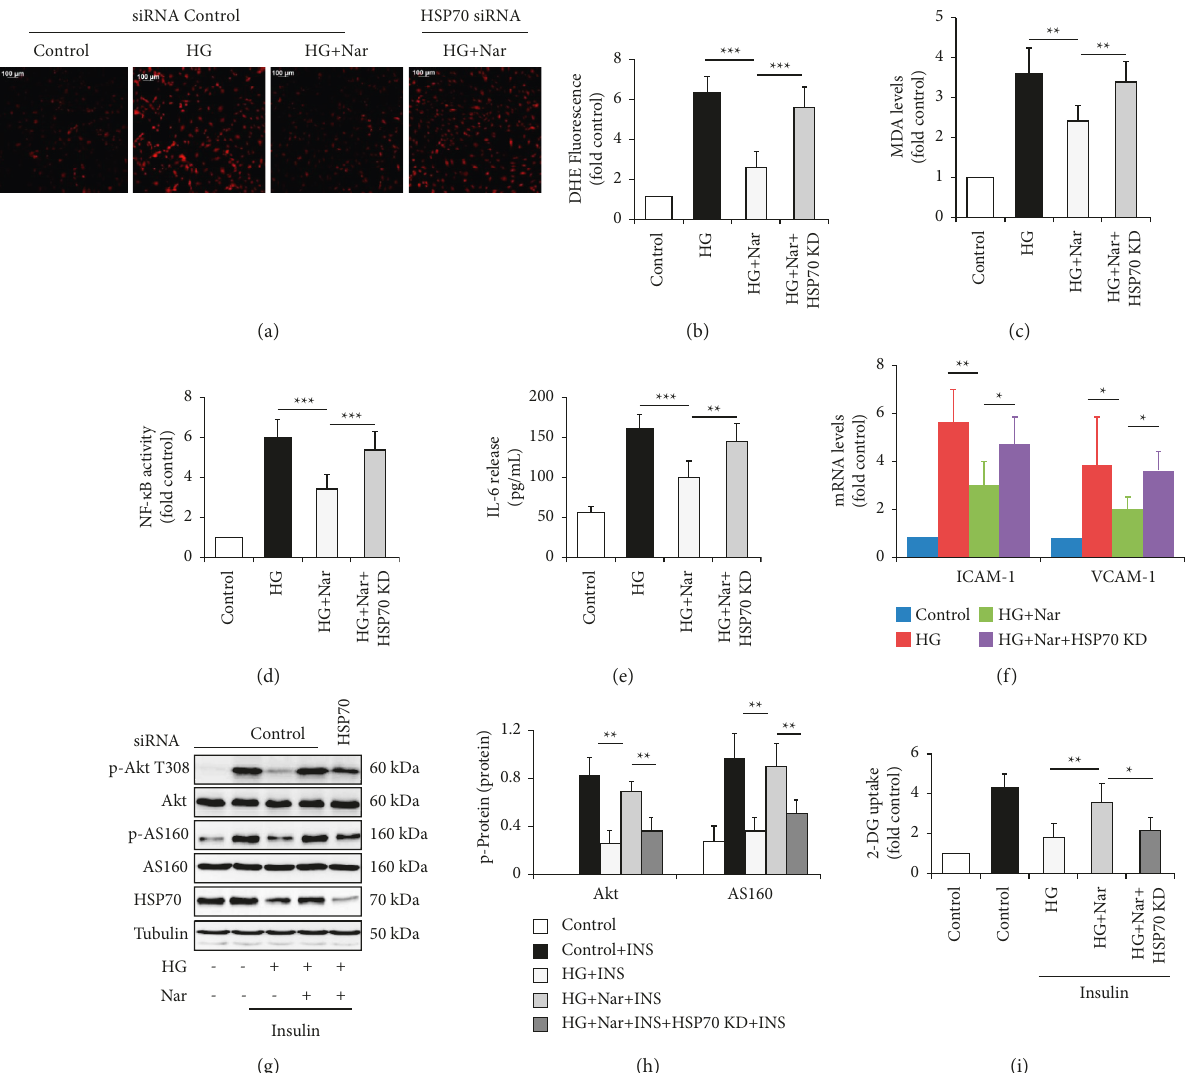
Figure 6: HSP70 knockdown (KD) attenuated the protective effect of Nar on HG-induced alterations of endothelial function. The siRNA technique was used to silence HSP70 in HG-treated HUVECs. The cells were then exposed to NG (5.5mM glucose) or HG (30 mM glucose) media with or without the 50 mM of Nar for 36 h. To observe the effect of Nar on insulin signaling, the cells were treated with or without 100nM of insulin for 10min. (a) Effect of HSP70 KD on ROS formation by DHE staining. (b) Quantification of relative DHE fluorescence in (a). (c) Effect of HSP70 KD on intracellular MDA concentration. (d) Effect of HSP70 KD on NF- κ B activity. (e) Effect of HSP70 KD on IL-6 concentration in the culture media. (f) Effect of HSP70 KD on mRNA levels of cell adhesion molecules ICAM-1 and VCAM-1. (g) Effect of HSP70 KD on insulin-stimulated phosphorylation of Akt and its downstream AS160. (h) Quantification of phosphorylated Akt and AS160 in (g). (i) Effect of HSP70 KD on insulin-stimulated 2-DG uptake. Data are expressed as means ± SD ( n � 3). ∗ P < 0 . 05, ∗∗ P < 0 . 01, and ∗∗∗ P < 0 . 001 versus the indicated